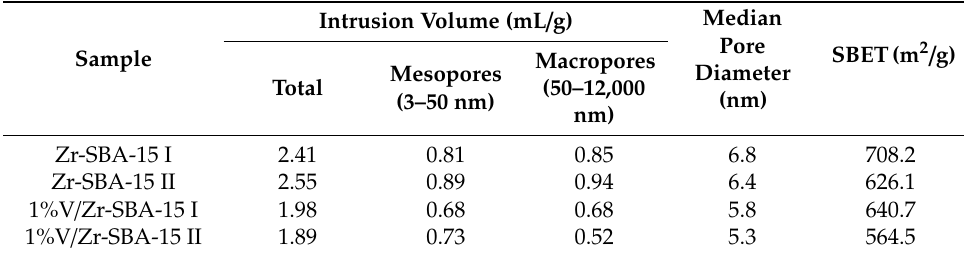
Table 3. Textural properties of used supports and